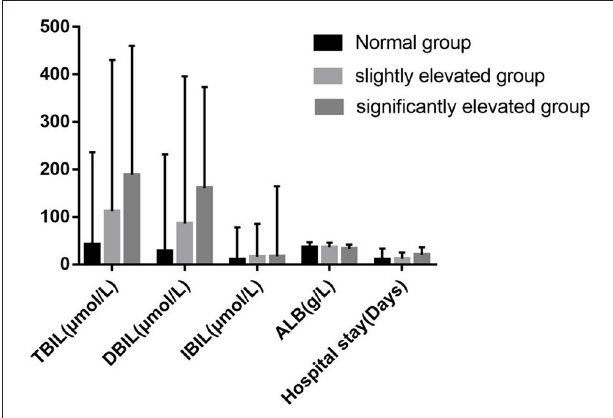
FIGURE 2 | Levels of clinical biochemical indexes in different groups of serum PIVKA-II levels. PIVKA, protein induced by vitamin K absence or antagonist-II.